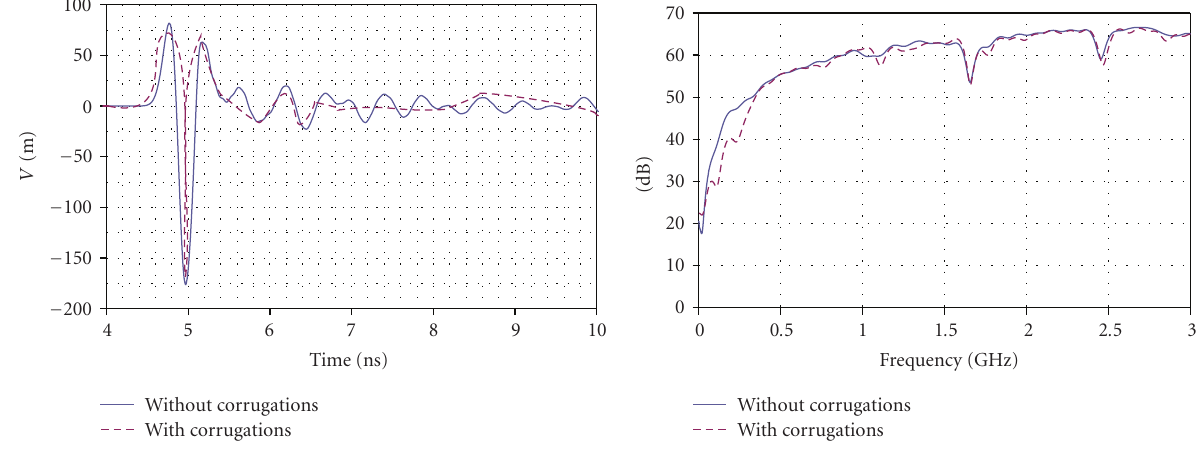
Figure 14: Front signal ( Ez ) with and without